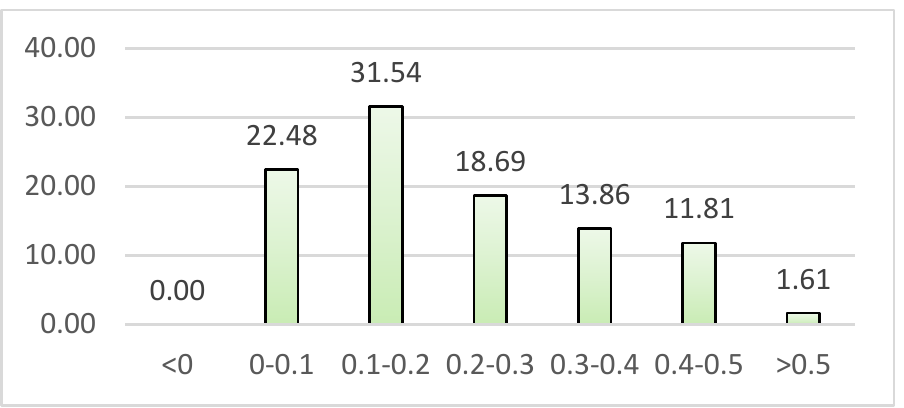
Figure 3. Distribution of NDVI Value in Medan in 2019. x NDVI values, y: percentage of areas (%). NDBI values range between − 1 and 1. The bigger the NDBI, the greater the built-up area portion. Figure 4 shows most of the area in Medan was built-up areas represented by higher NDBI values (with red color). Some green spaces and water body found in the upper area of Medan. The site included mangroves, fish ponds, mixed gardens, and paddy fields.